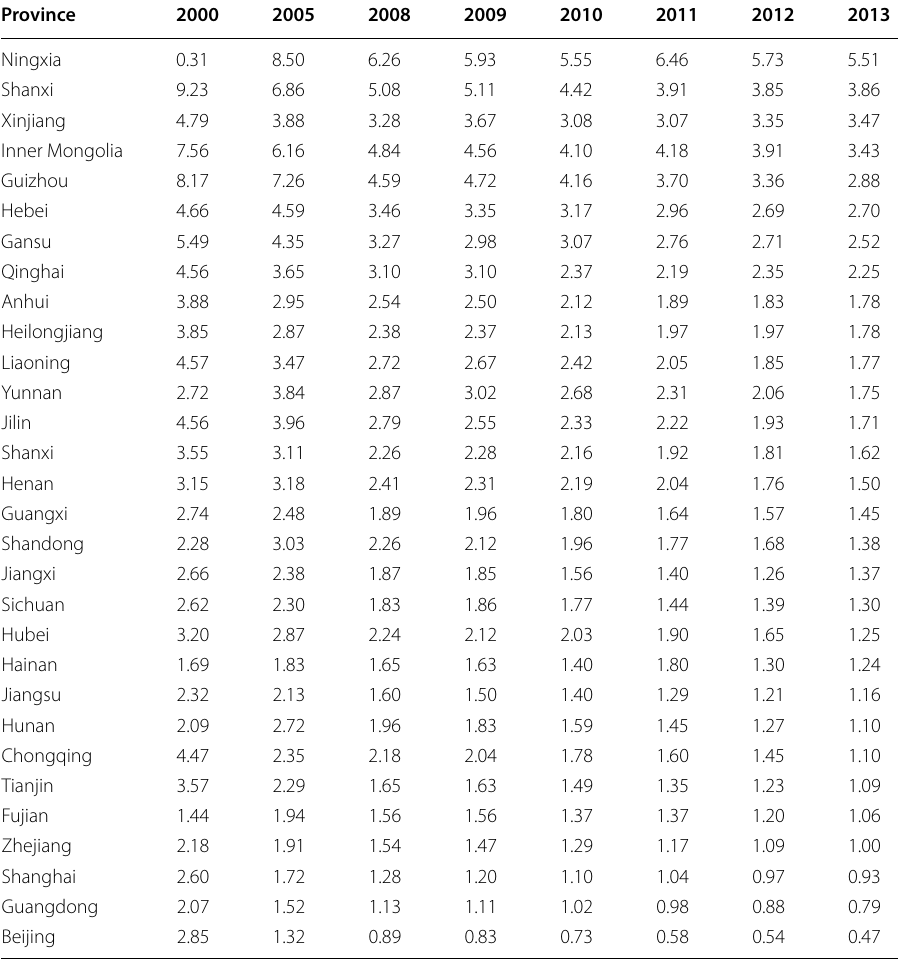
Table 2 The energy intensity in various provinces in 2013(unit: tons/10 4 yuan RMB) Province